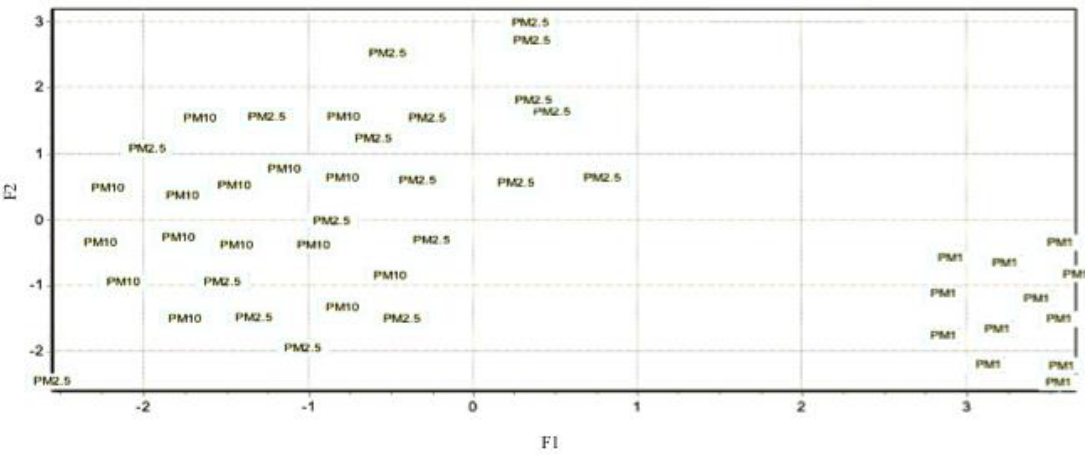
Figure 4. Airborne filter identification in two groups using the discriminant functions.